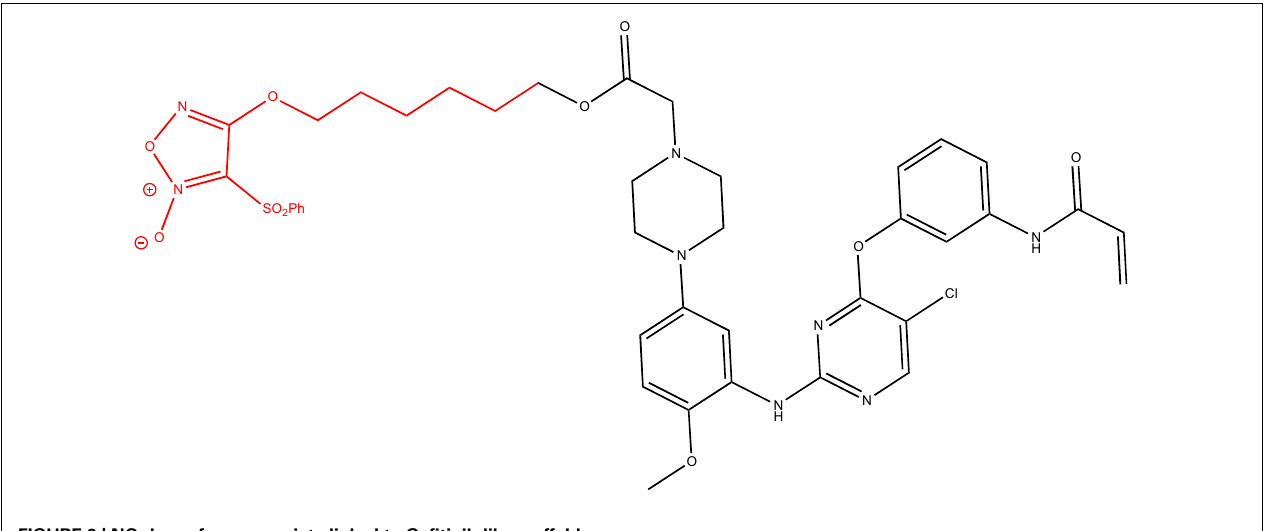
FIGURE 8 | NO-donor furoxan moiety linked to Gefitinib-like scaffold .